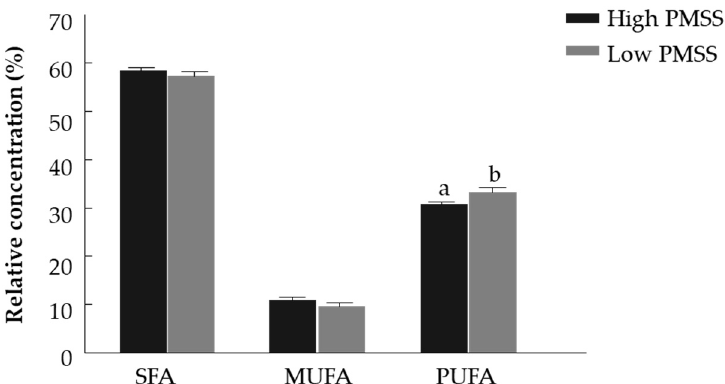
Figure 4. Relative concentration of saturated (SFA), monounsaturated (MUFA) and polyunsaturated (PUFA) fatty acids in fresh spermatozoa with high and low progressively motile spermatozoa’s survival (PMSS). Data are presented as mean ± SEM. Different letters above columns indicate significant differences between groups within PUFA relative concentrations at p < 0.005 .